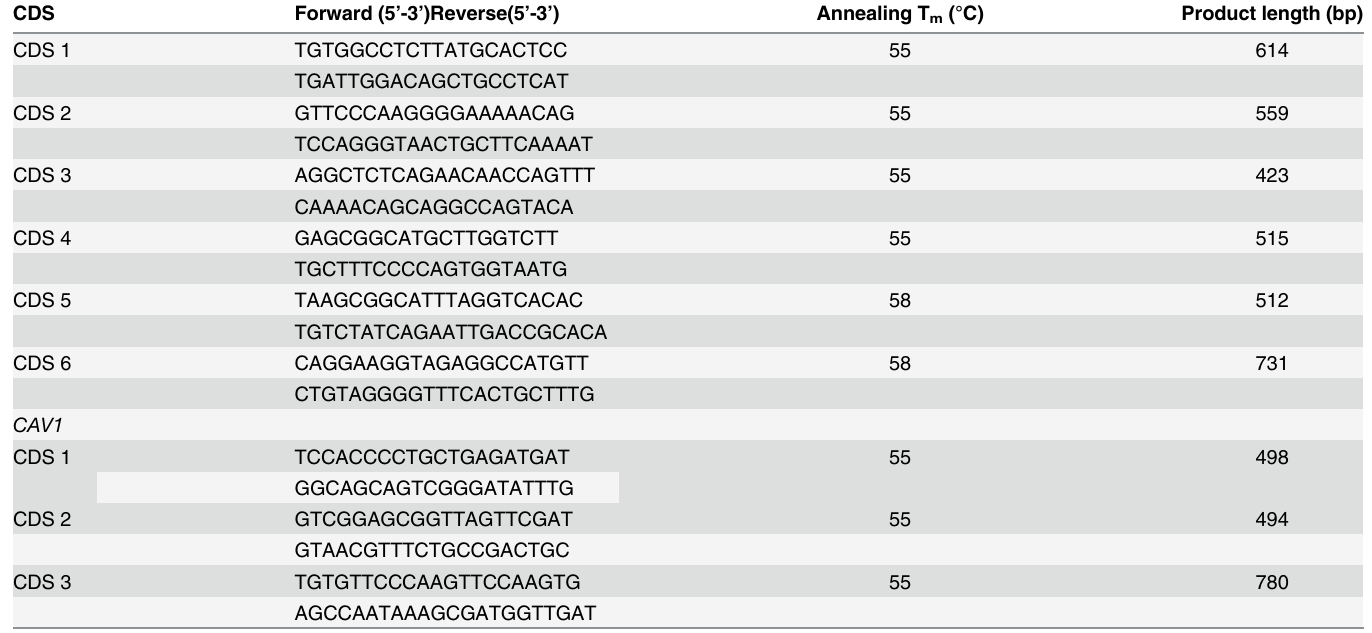
were predicted to be benign. Three patients had multiple point mutations. The large size rearrangement analysis is summarized in Table 5. Three patients had more than one large size rearrangements.